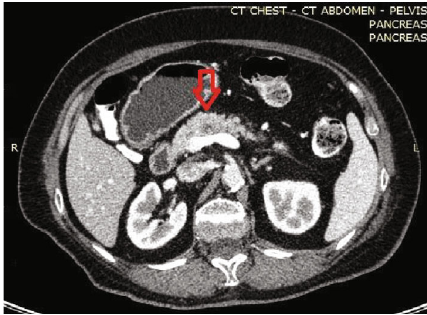
Figure 1: Computed tomography (CT image) demonstrating a hypodense pancreatic mass (red arrow) anterior to the superior mesenteric vein and splenic vein con fl uence.